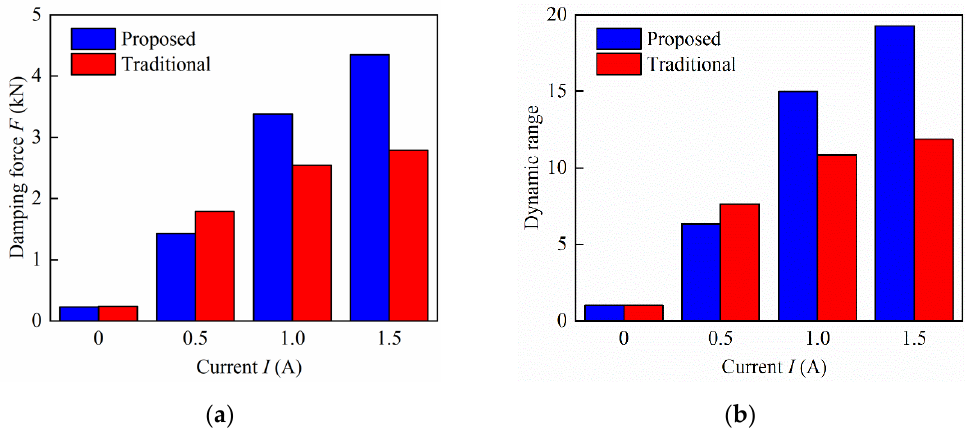
Figure 18. Comparison of the damping performance between the proposed and the traditional MR damper: ( a ) Damping force versus current; ( b ) Dynamic range versus current.